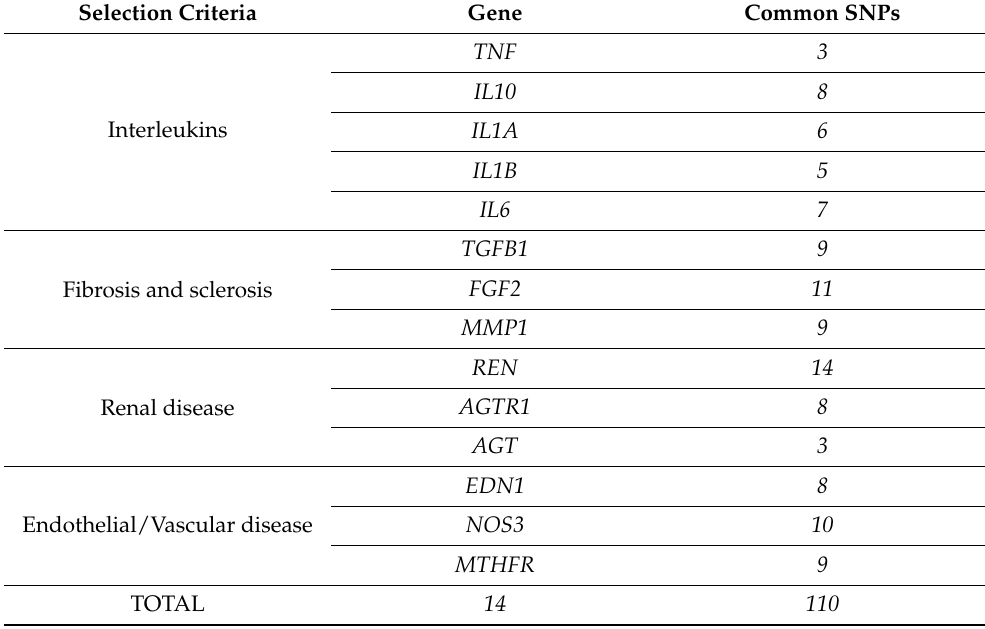
Table 1. List of the genes and their total number of common SNPs in proximal promoters that were analyzed with SNPClinic v.1.0